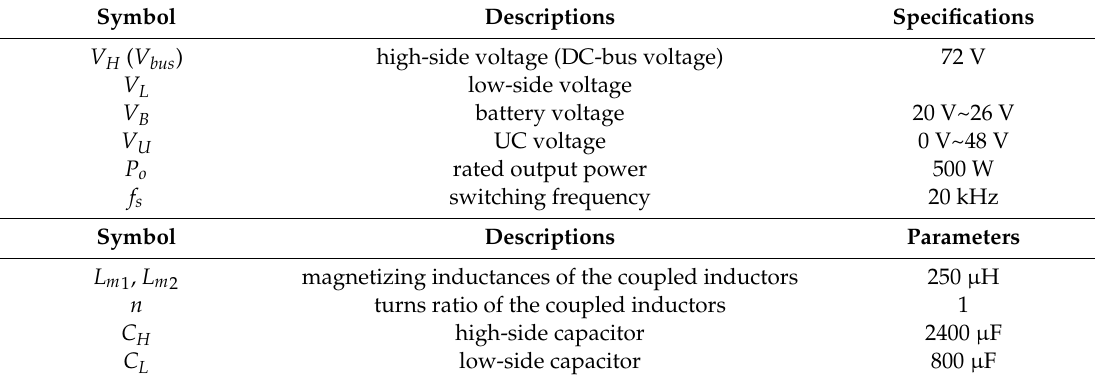
Table 1. Specifications and circuit parameters of the realized power converter.